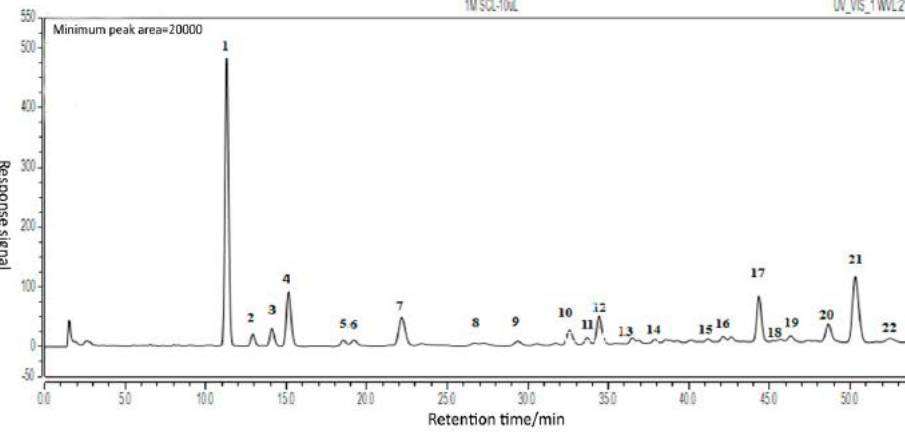
Figure 2. The common peaks of characteristic HPLC chromatogram of TDL from S. chinensis. Table 1. The average peak area and relative retention time of the twenty-three common characteristic peaks. Retention Peaks